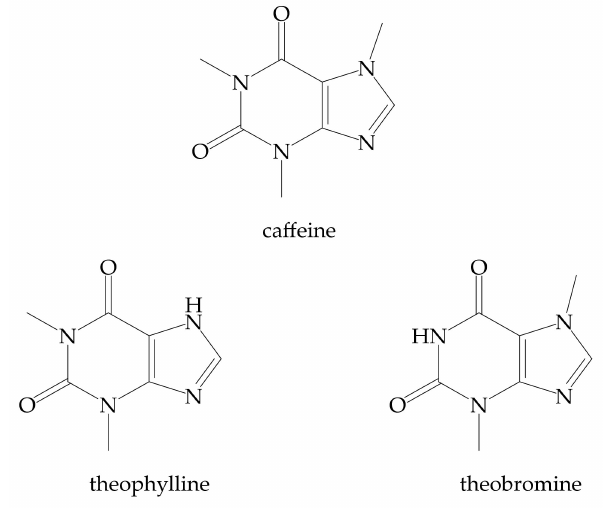
Figure 7. Structures of the most widespread